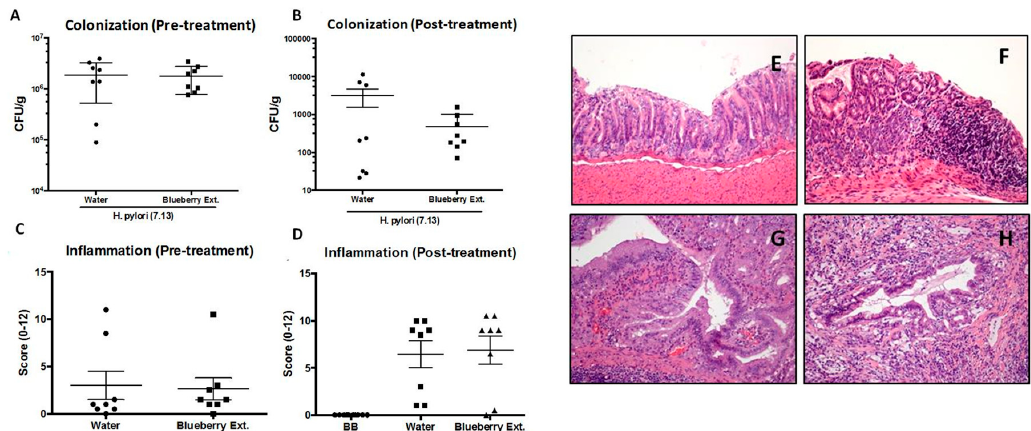
Figure 5. E ff ect of blueberry extracts enriched with anthocyanins over H. pylori colonization and injury on Mongolian gerbil gastric mucosa. ( Left ) Gastric inflammation 6–12 weeks after the challenge was assessed and scored (0 to 12) in uninfected (UI) and H. pylori -infected gerbils. Each data point represents the inflammation score from a single gerbil. Mean values are shown, and Mann–Whitney U tests were used to determine statistical significance between groups. ( Right ) Wild-type H. pylori strain 7.13 induces gastric inflammation, dysplasia, and adenocarcinoma in Mongolian gerbils. Hematoxylin and eosin–stained tissues (8 weeks after challenge) were evaluated for parameters of inflammation and injury by histopathology: Representative images of ( E ) uninfected gastric mucosa; ( F ) H. pylori -induced gastritis; ( G ) H. pylori -induced dysplasia; and ( H ) H. pylori -induced adenocarcinoma. Original magnification, ×200.